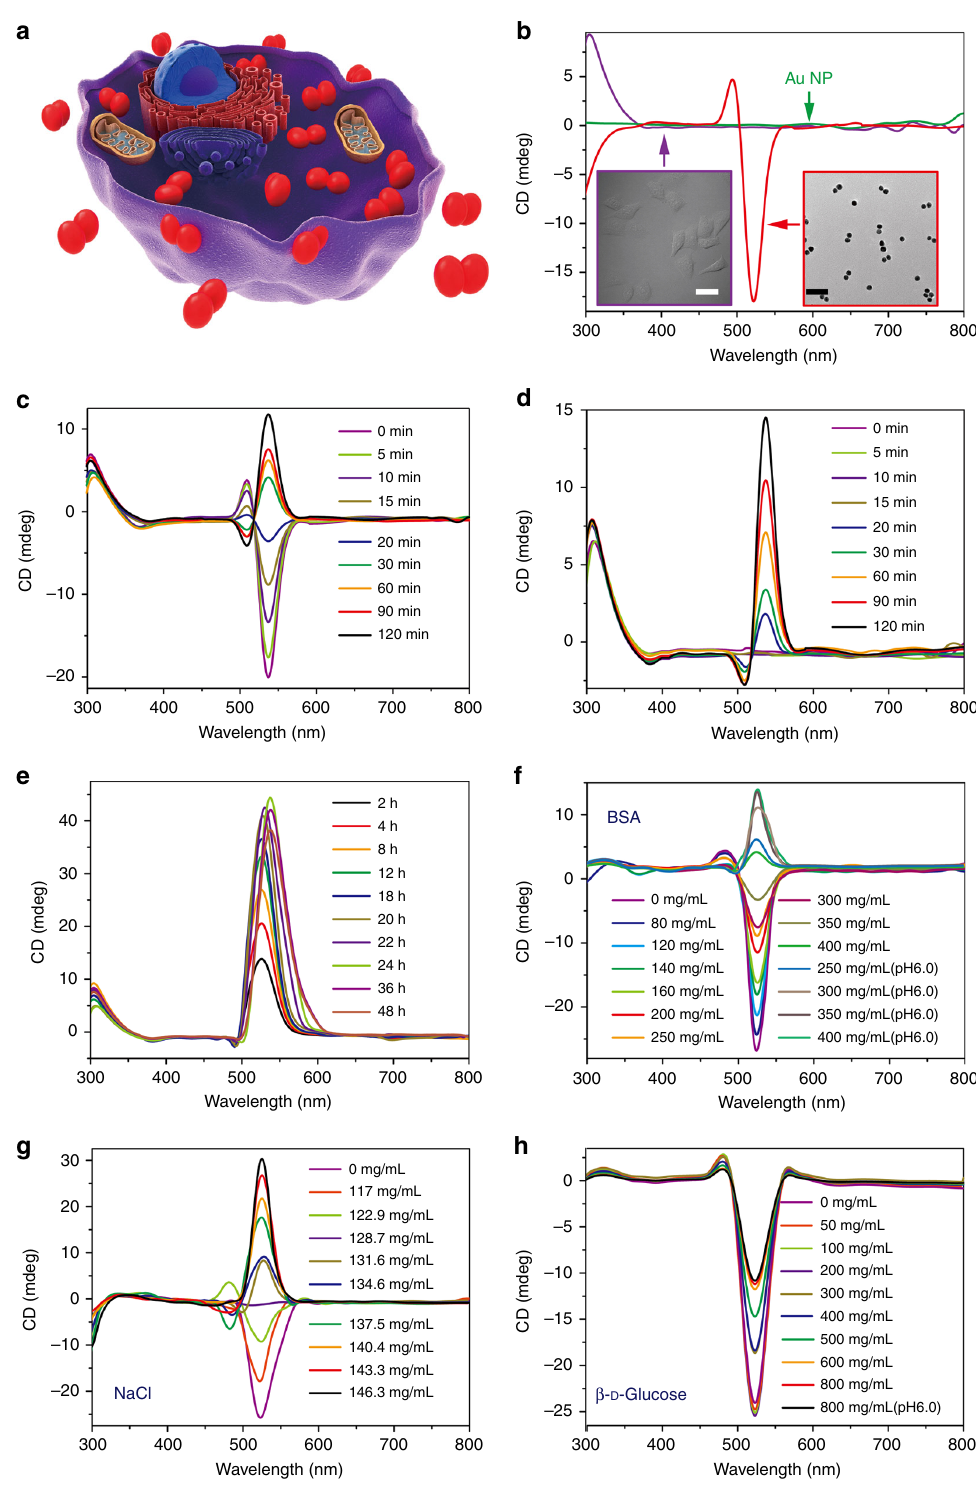
Fig. 1 Temporal progressions of chiroptical activity of NP dimers for transmembrane transport in HeLa cells and other conditions. a Schematics of NP dimers in a model cell; b CD spectra of individual NPs, HeLa cells and NP dimers in the PBS buffer. Scale bar: 100 nm. c , d CD spectra of NP dimers incubated with HeLa cells over a period of 2 h; The spectroscopic measurements for each time point were performed before and after the removal of extracellular dimers. e CD spectra of NP dimers incubated with HeLa cells over a period of 48 h; The spectroscopic measurements for each time point were performed after the removal of extracellular dimers as in d . f – h CD spectra of NP dimers in BSA, NaCl and β - D -glucose solutions with various concentrations as given in the